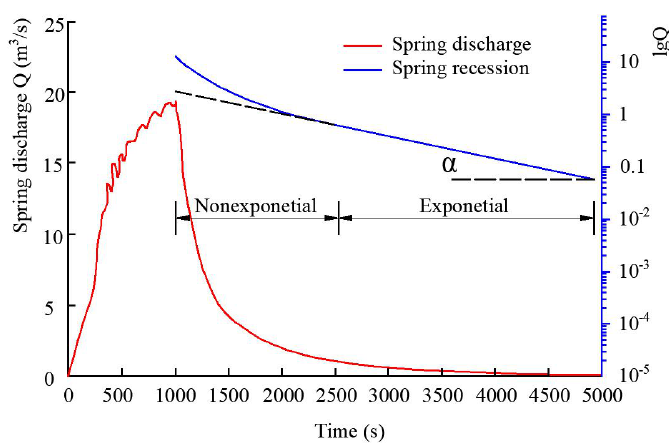
Figure 12. The spring hydrograph and recession curve of scenario A on the logQ-t plot.